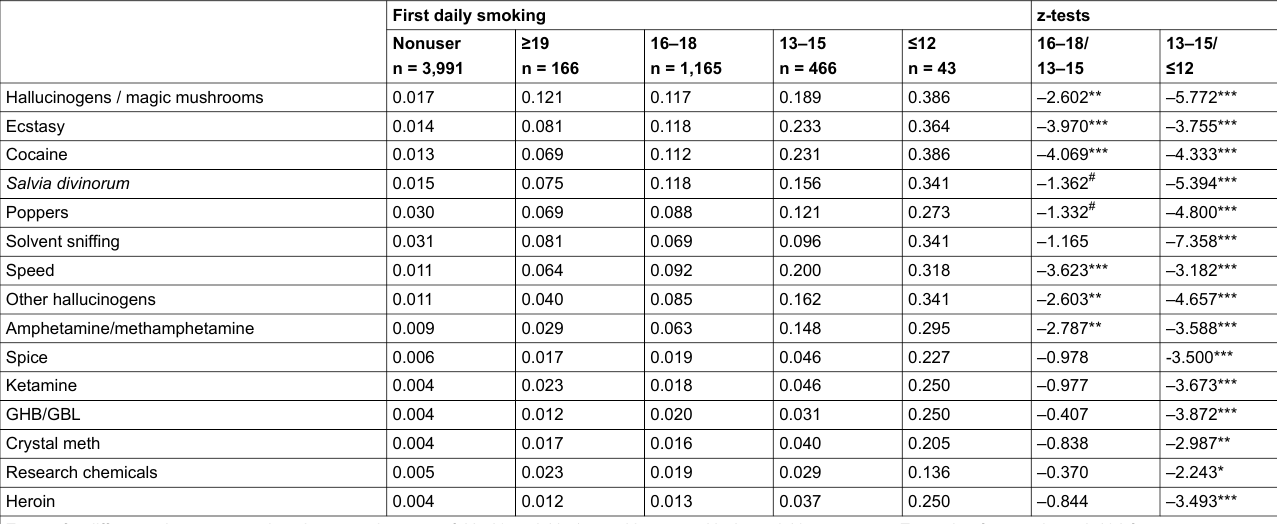
Table 7: Proportion of drug users within age categories for onset of intensive use of